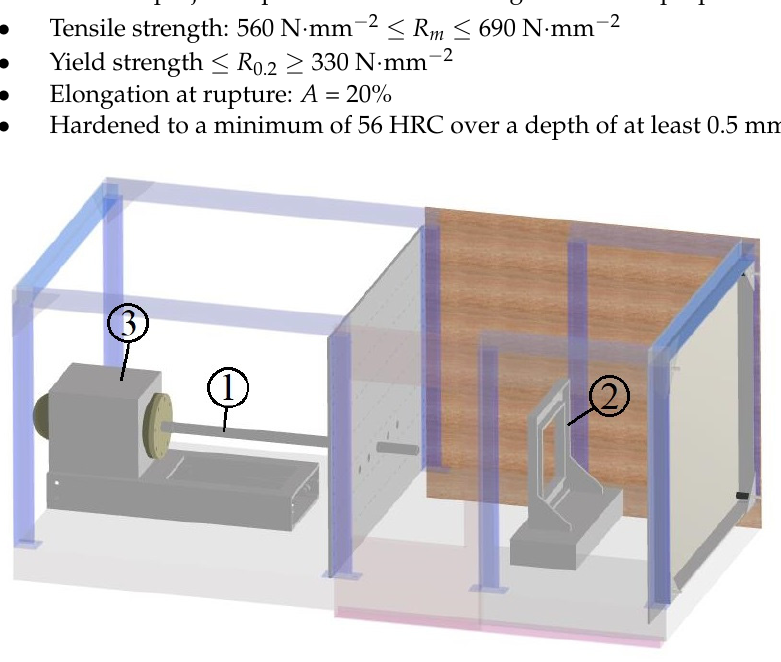
Figure 2. Test rig for ballistic penetration: (1) compressed air gun, (2) clamping and support frame with test panel, and (3) compressed air tank.